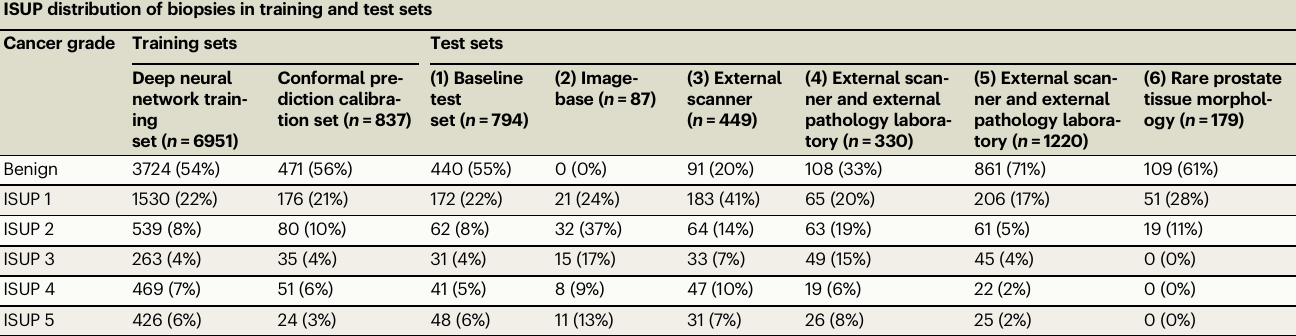
Table 1 | Baseline characteristics of biopsy cores from the training data and the six different test datasets used for evaluation of the AI system and the conformal predictor ISUP distribution of biopsies in training and test sets Cancer grade Training